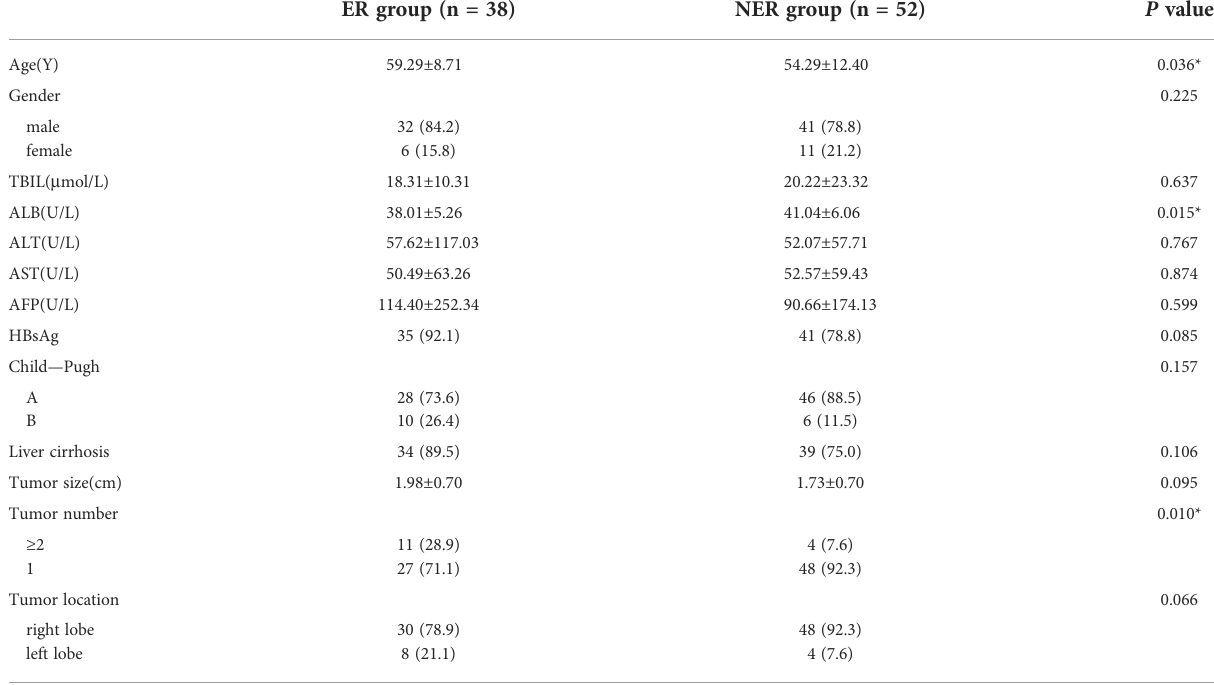
TABLE 1 The baseline data of patients with small liver cancer in ER cohort and NER